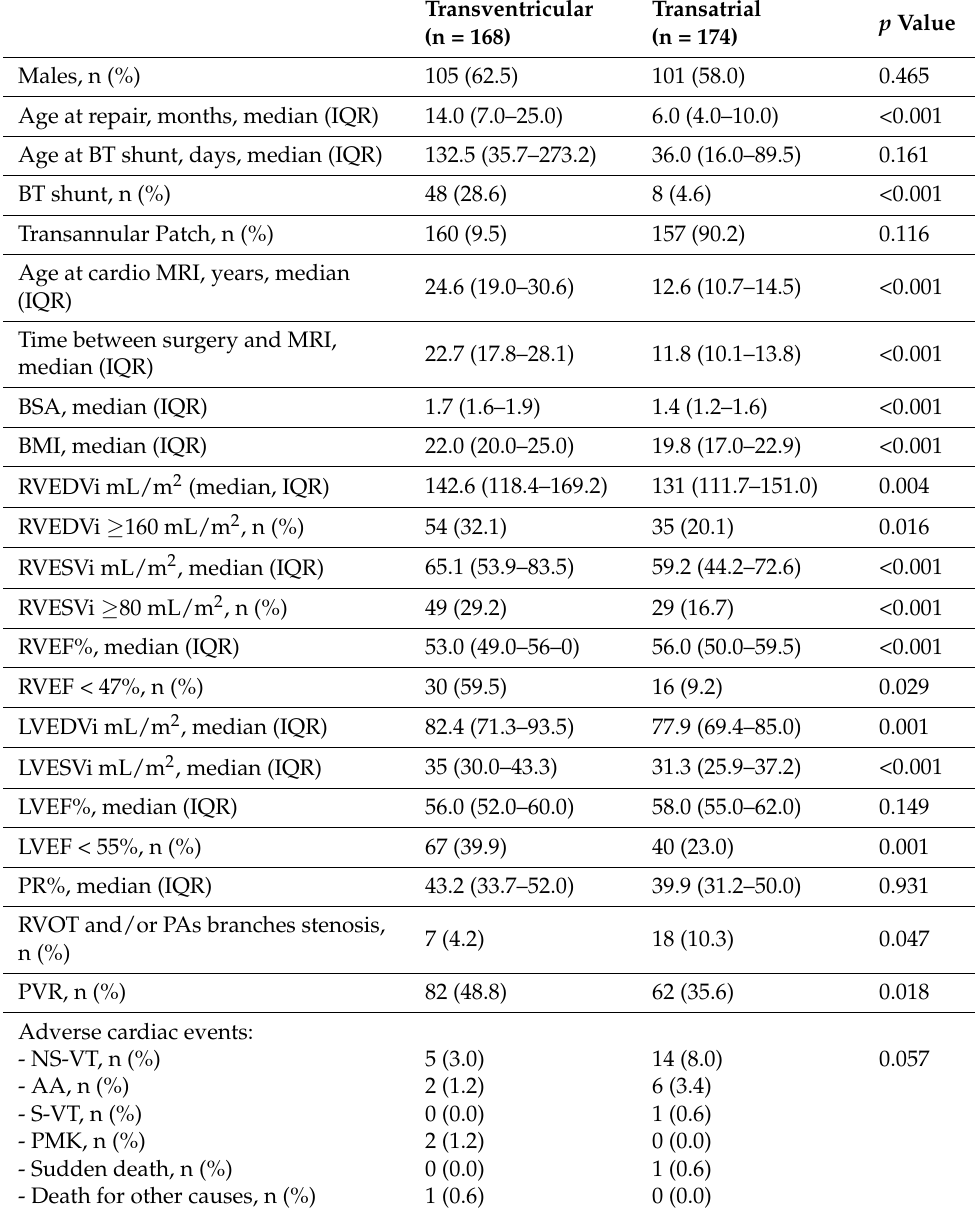
Table 5. Clinical and MRI characteristics according to VSD closure approach. Legend: BT shunt = Blalock–Taussig shunt; TP = transannular patch; BSA = body surface area; BMI = body mass index; RVEDVi = right ventricular end-diastolic volume indexed by BSA; RVESVi = right ventricular end- systolic volume indexed by BSA; RVEF = right ventricular ejection fraction; LVEDVi = left ventricular end-diastolic volume indexed by BSA; LVESVi = left ventricular end-systolic volume indexed by BSA; LVEF = left ventricular ejection fraction; PR = pulmonary regurgitation fraction; RVOT = right ventricular outflow tract; PAs = pulmonary arteries; PVR = pulmonary valve replacement; NS-VT = non-sustained ventricular arrhythmias; S-VT = sustained ventricular arrhythmias; AA = atrial arrhythmia; PMK =